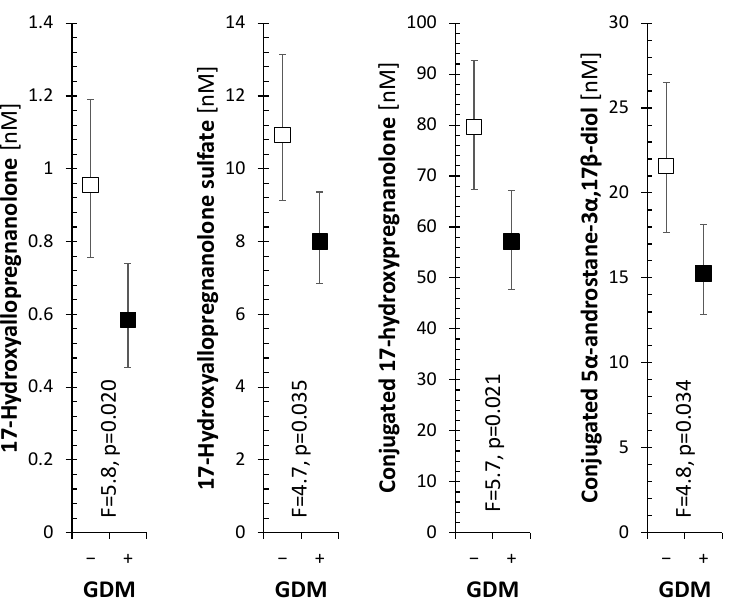
Figure 1. Levels of steroids showing significant differences between GDM − and GDM+ groups in mixed umbilical cord blood as evaluated by ANOVA adjusted to sex of the fetus and presence of thyropathy in mother. Empty and full squares with error bars represent retransformed means with their 95% confidence intervals for GDM− and GDM+ women, respectively. F is the F-statistics and p is the p -value for the factor GDM.